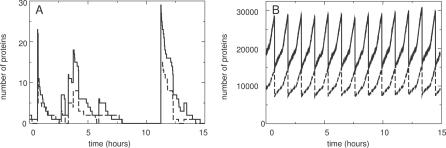
Protein Dynamics of the Stochastic Model(A) Protein dynamics for a repressed operon. The solid line indicates the number of permease molecules, the dashed line the number of β-galactosidase molecules.(B) Protein dynamics for an induced operon.